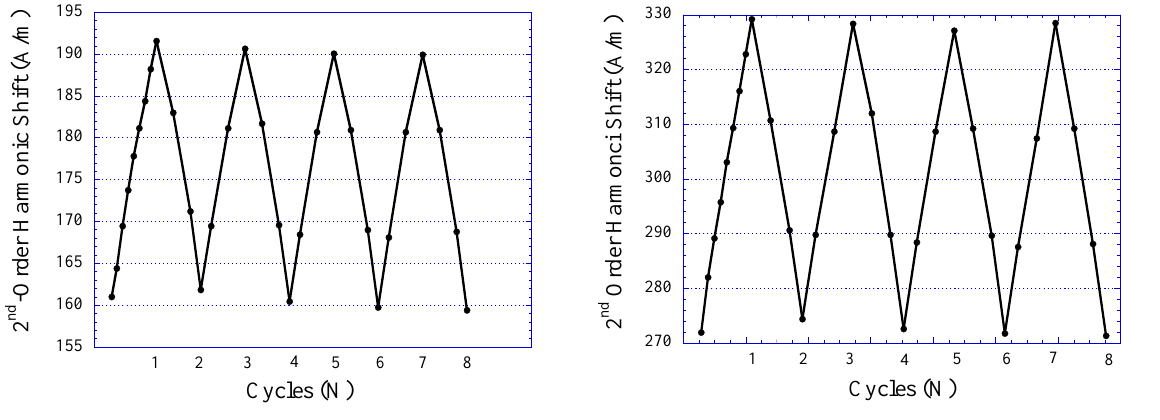
Figure 11. The repeatability of the 2nd-order harmonic shift produced by Sensor I ( left ) and Sensor II ( right